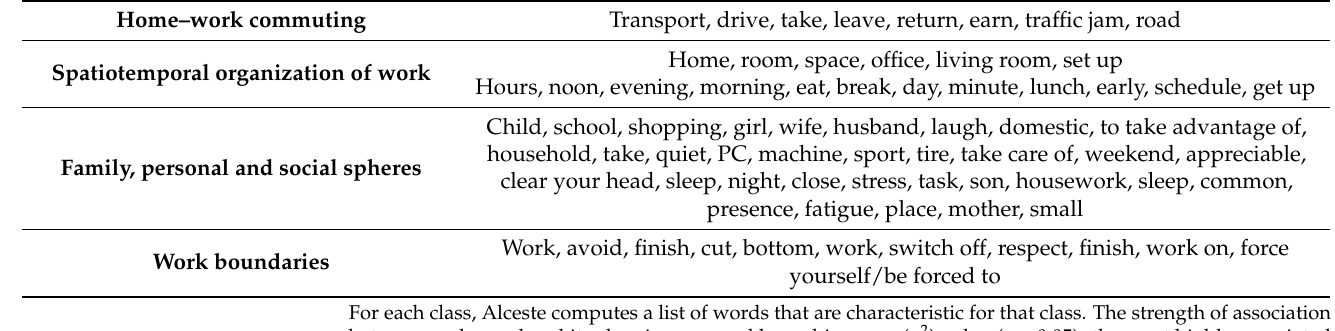
Table 2. Themes associated with the specific vocabulary of Class